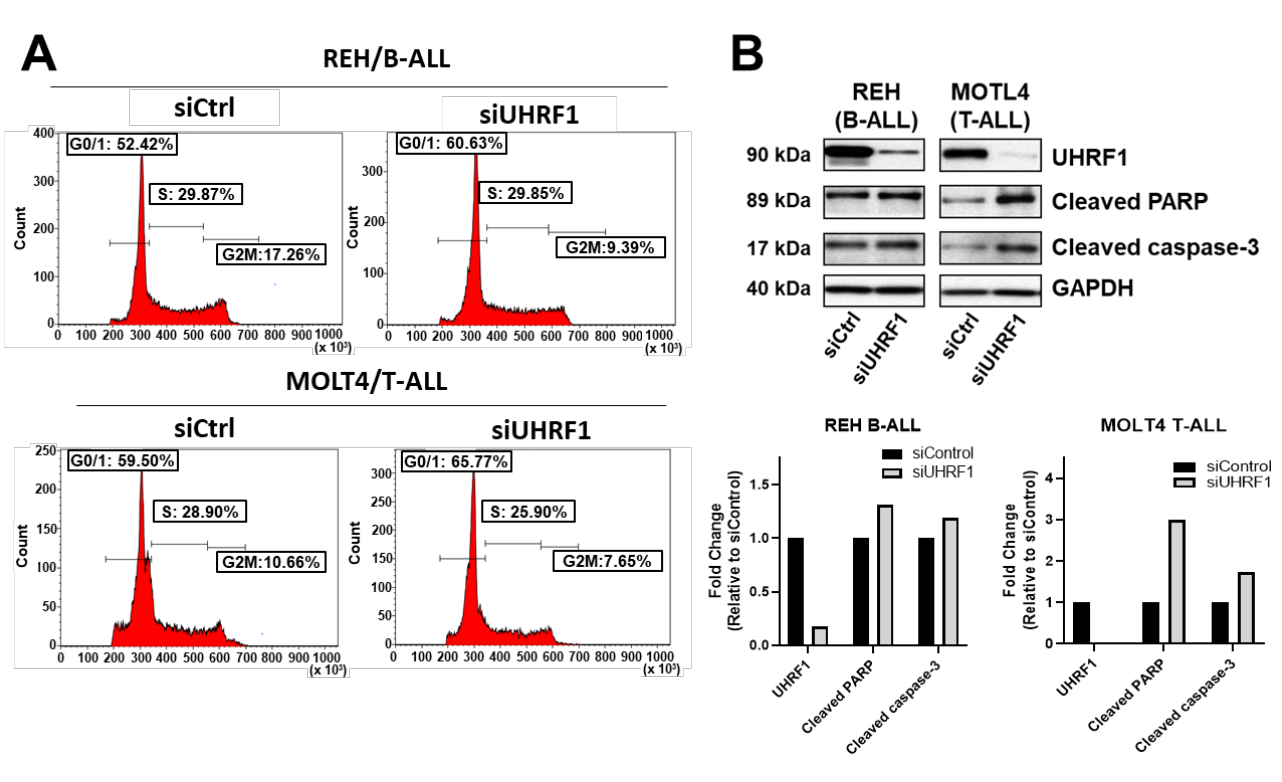
Figure 4. Knockdown of UHRF1 induces accumulation of cells in the G0/G1-phase and apoptosis. ( A ) Cell cycle analysis of REH B-ALL and MOLT4 T-ALL cells following a siRNA-mediated knockdown of UHRF1. ( B ) Immunoblots for UHRF1, cleaved PARP, and cleaved caspase-3 following a siRNA-mediated knockdown of UHRF1 in REH B-ALL and MOLT4 T-ALL cells. Densitometry measurements normalized against GAPDH loading control are provided. The uncropped blots are shown in Figure S1.